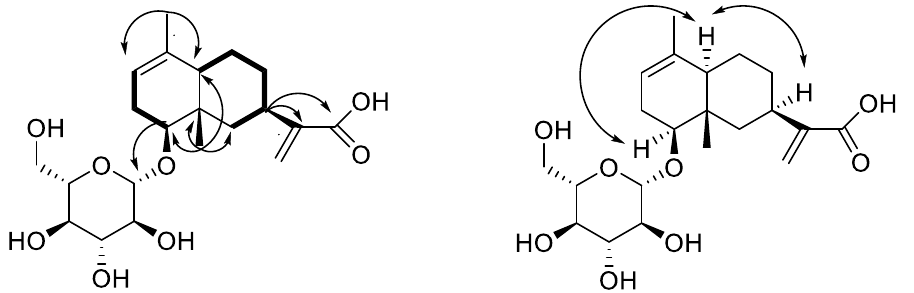
Figure 3. Main 1 H- 1 H COSY (bold lines), HMBC (arrows) and NOE (double arrows) correlations of compound 2 .